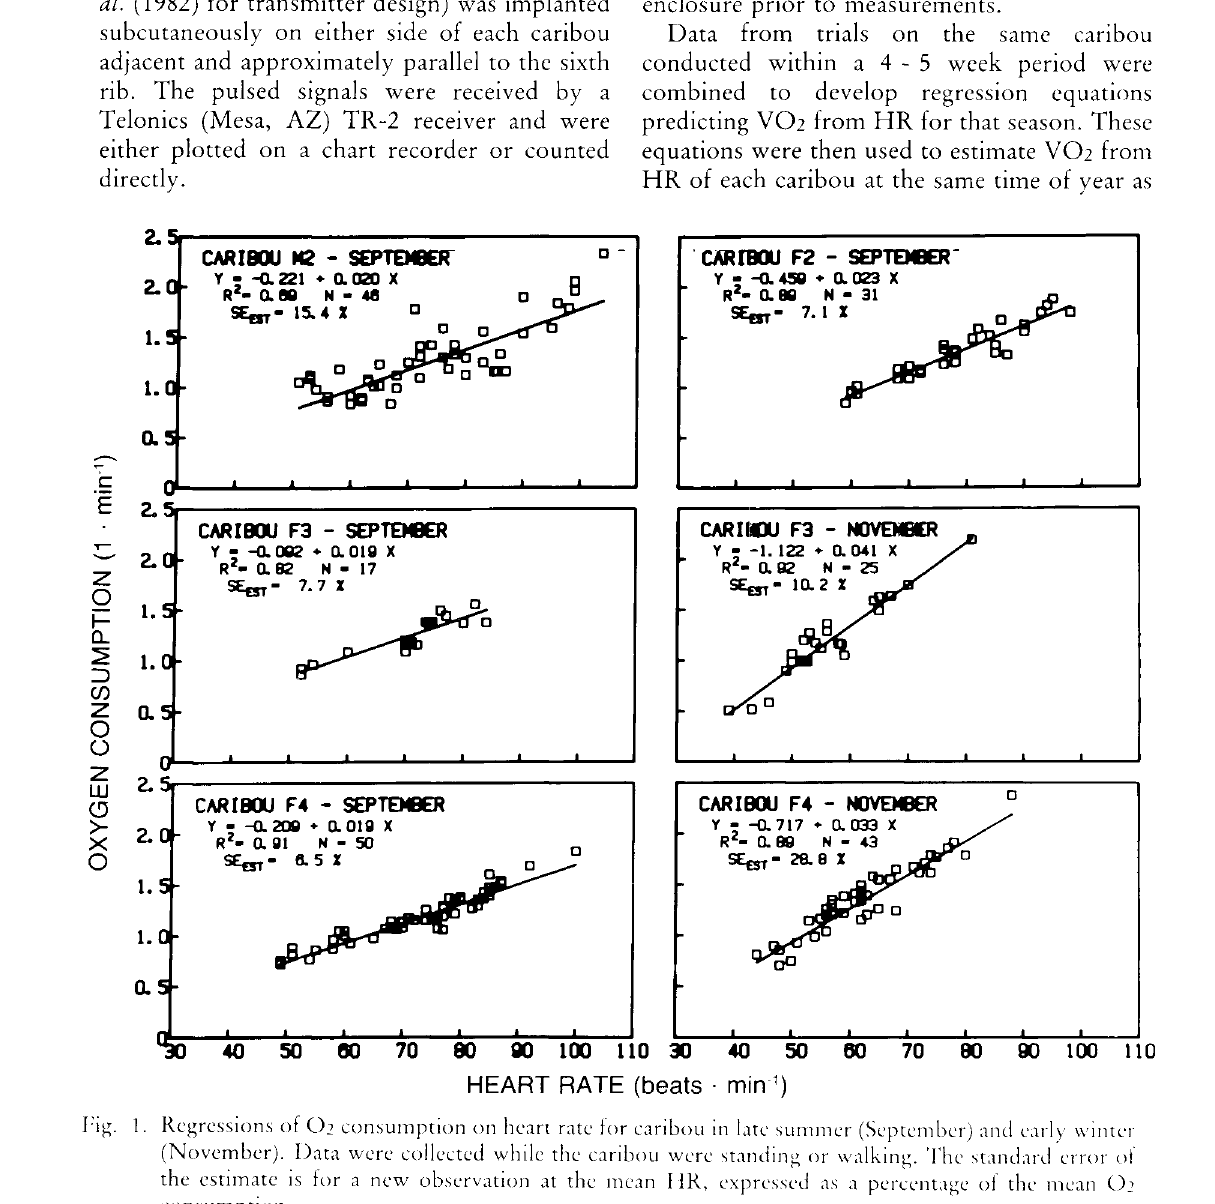
1. Regressions of O2 consumption on heart rate for caribou in late summer (September) and early winter (November). Data were collected while the caribou were standing or walking. The standard error of the estimate is for a new observation at the mean HR, expressed as a percentage of the mean O2